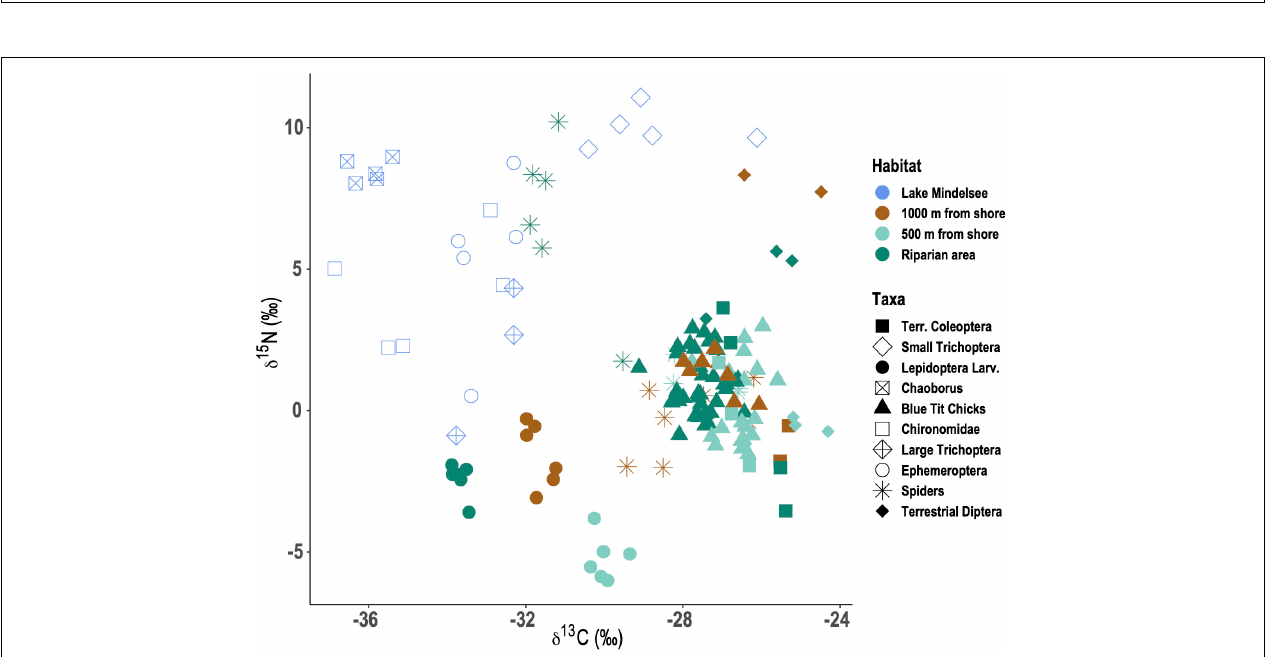
FIGURE 4 | Bulk nitrogen stable isotope ( δ 15 N) and carbon stable isotope ( δ 13 C) values for aquatic and terrestrial taxa emerging from and found at three distances from Lake Mindelsee (i.e., the riparian area, ∼ 500 m from shore, and ∼ 1,000 m from shore). Colors indicate habitat origin of taxa (aquatic or terrestrial) and distance from Lake Mindelsee for terrestrial taxa. Lepidoptera here are larval Lepidoptera (i.e., caterpillars).